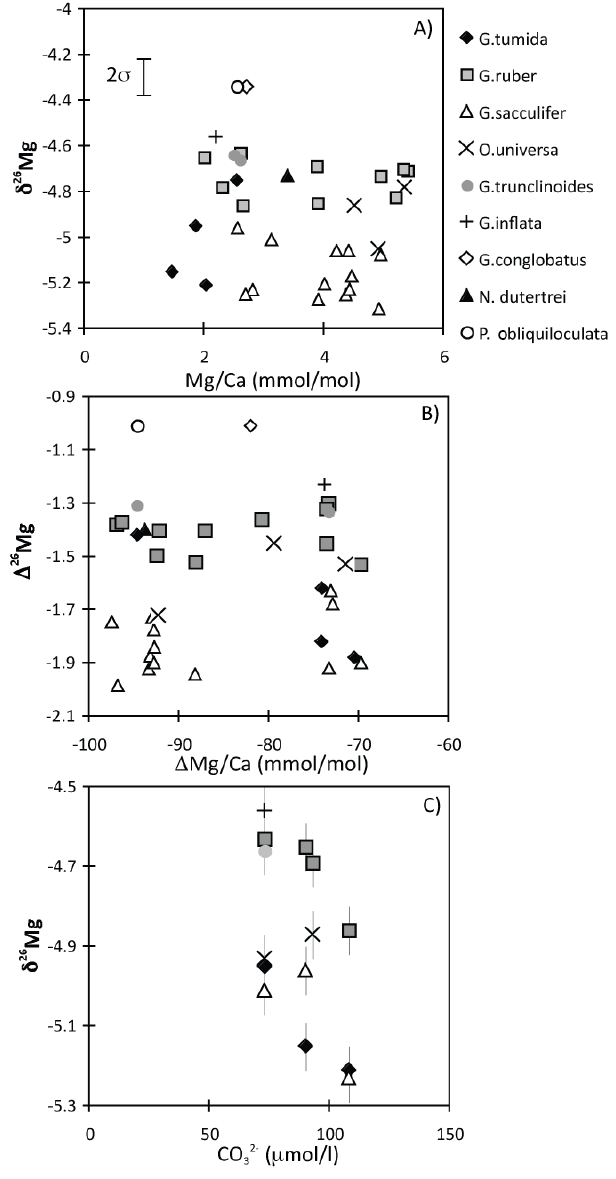
Figure 2. (a) Mg/Ca ratios vs. δ 26 Mg of all species analysed (in- cluding from Pogge von Strandmann, 2008). No relationship exists between these two factors. (b) The Mg/Ca and δ 26 Mg fractionation after inorganic calcification (temperature-dependent for Mg/Ca) has been removed, showing the extent of biologically controlled impacts on magnesium and its isotopes in foraminifers. (c) Rela- tionship between δ 26 Mg and carbonate ion concentration. The error bars represent external uncertainty (2SD), to demonstrate that the potential relationships hinge on single data